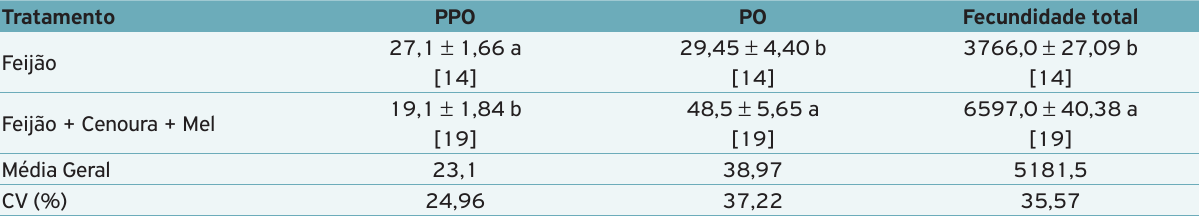
Tabela 1. Período (dias) de pré-oviposição ± Erro Padrão, oviposição e fecundidade total de adultos de Diabrotica. speciosa alimentados com diferentes dietas em condições